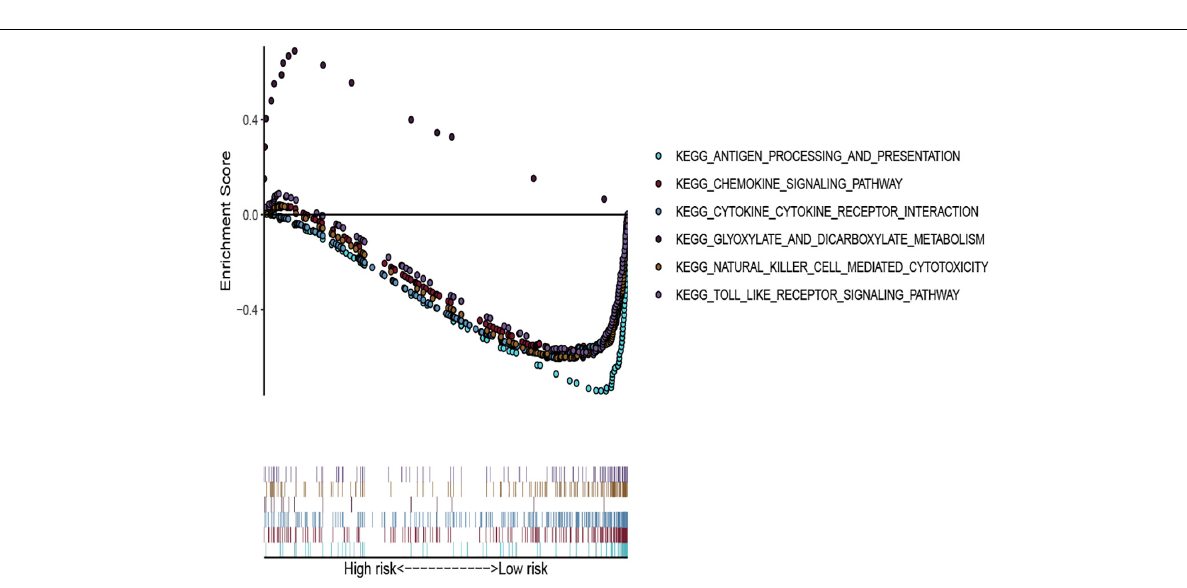
FIGURE 6 | The nomogram of training set applied to predict the survival (A) . Calibration plots used to predict the 3- (B) , and 5-year survival (C) .